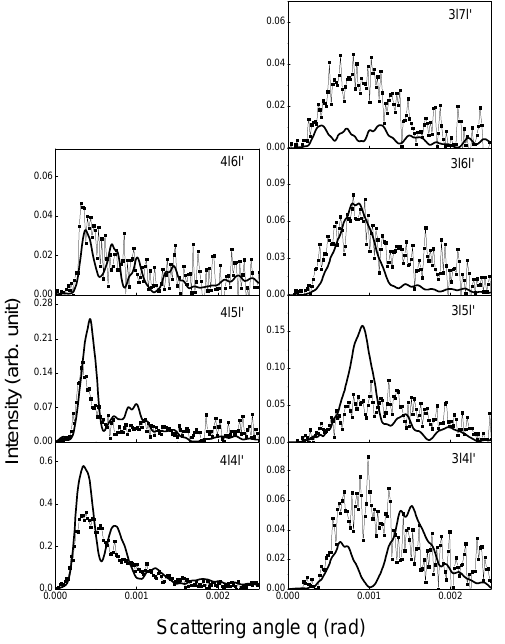
10+ + He collisions. Full curves, theory [19]; squares, experiment.